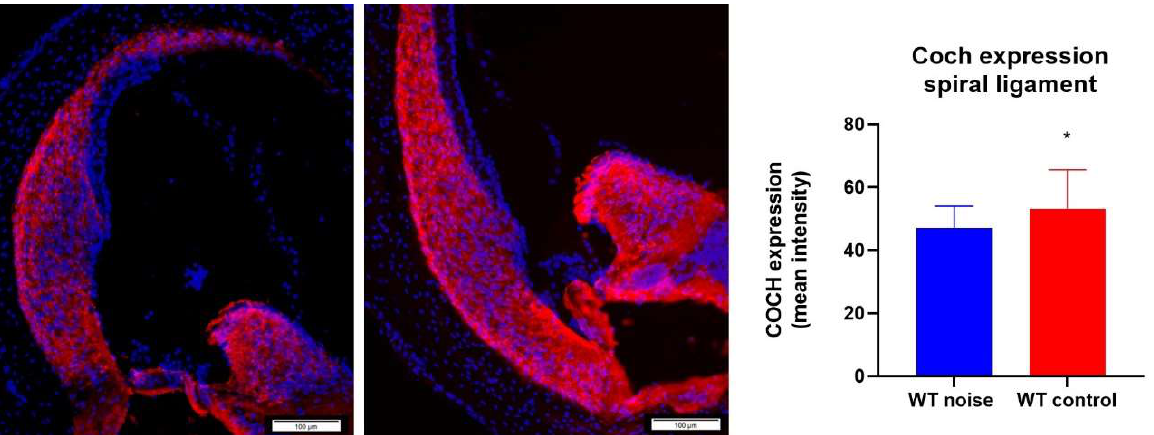
Figure 9. Cochlin expression ( COCH antibody, red) in the spiral ligament between Coch +/+ mice that were exposed to noise (n = 13) ( left ) and Coch +/+ mice that belong to the control group ( n = 9 ) ( middle ). Coch expression was measured in ImageJ. A significant difference was found in Coch expression between both group where the noise exposure group had significant lower levels of Coch expression than the wildtype control group. * indicates p < 0.05.